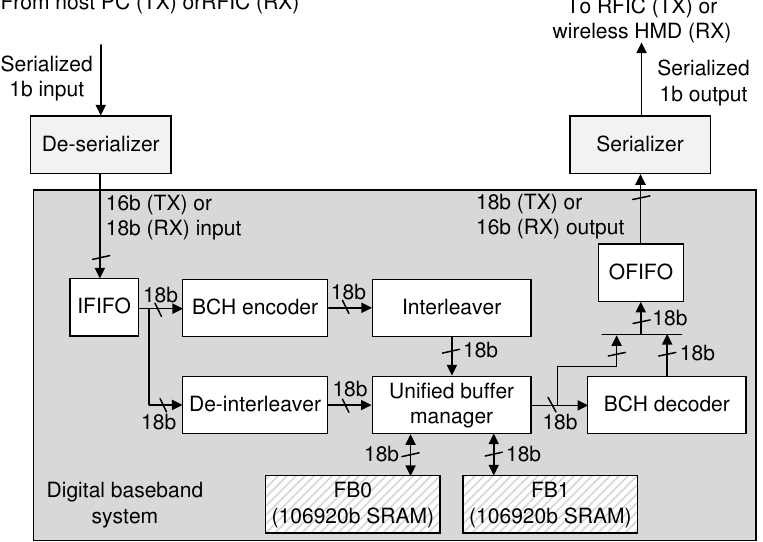
Figure 7. Block diagram of the proposed digital baseband